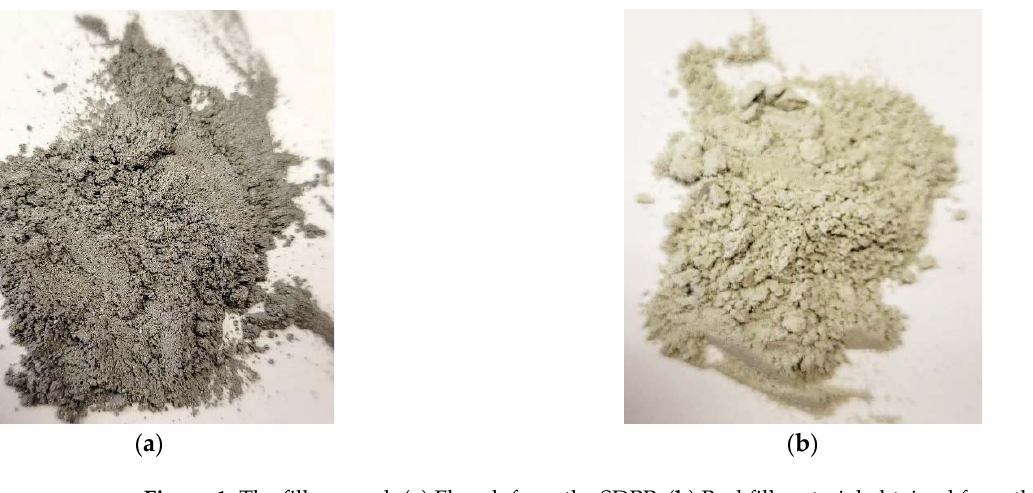
Figure 1. The fillers used: ( a ) Fly ash from the SDPP; ( b ) Backfill material obtained from the mineral processing waste of the copper-mining plant.